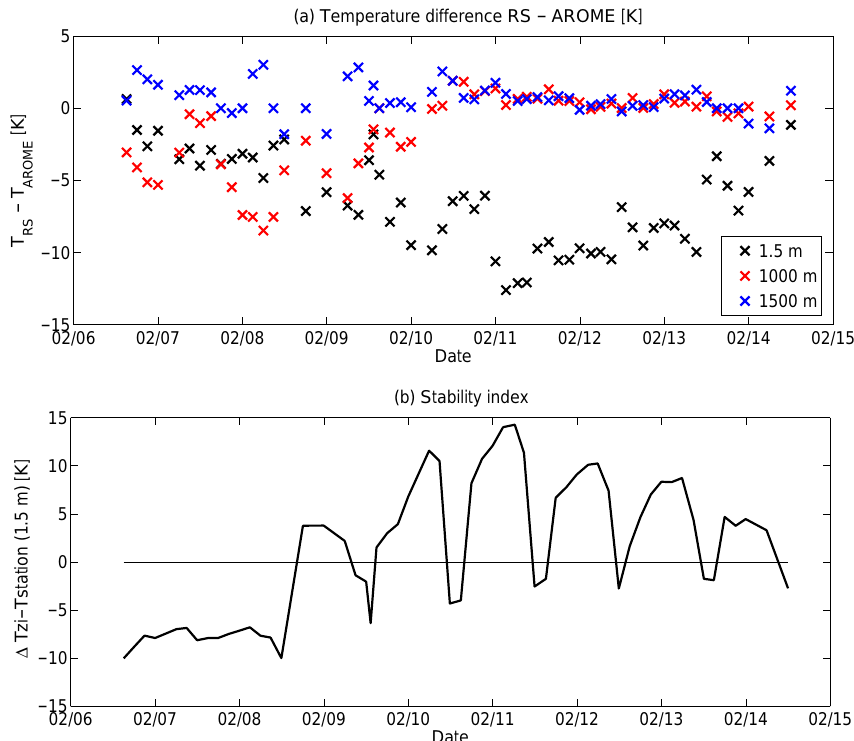
Figure 3. (a) Temperature differences between radiosondes and AROME analyses at three levels: 1.5m in black, 1000m in red and 1500m in blue. (b) Temperature differences between the radiosonde measurement at the boundary layer height and the surface measurement from an external weather station. Altitudes are given in meters above ground level.